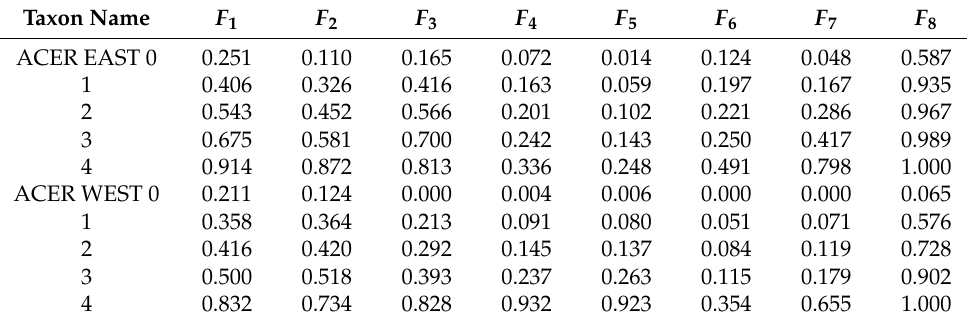
Figure 16 is the result of PCA using the quantile method. Four line segments connect- ing from 0% to 100% quantile vectors in the factor plane represent each hardwood. East hardwoods have similar shapes, while west hardwoods show significant differences in the last line segments connecting from 75% to 100% quantile vectors. We can recognize three clusters, (Acer West, Alnus West), (five east hardwoods), and (Fraxinus West, Juglans West, Quercus West), in this factor plane.